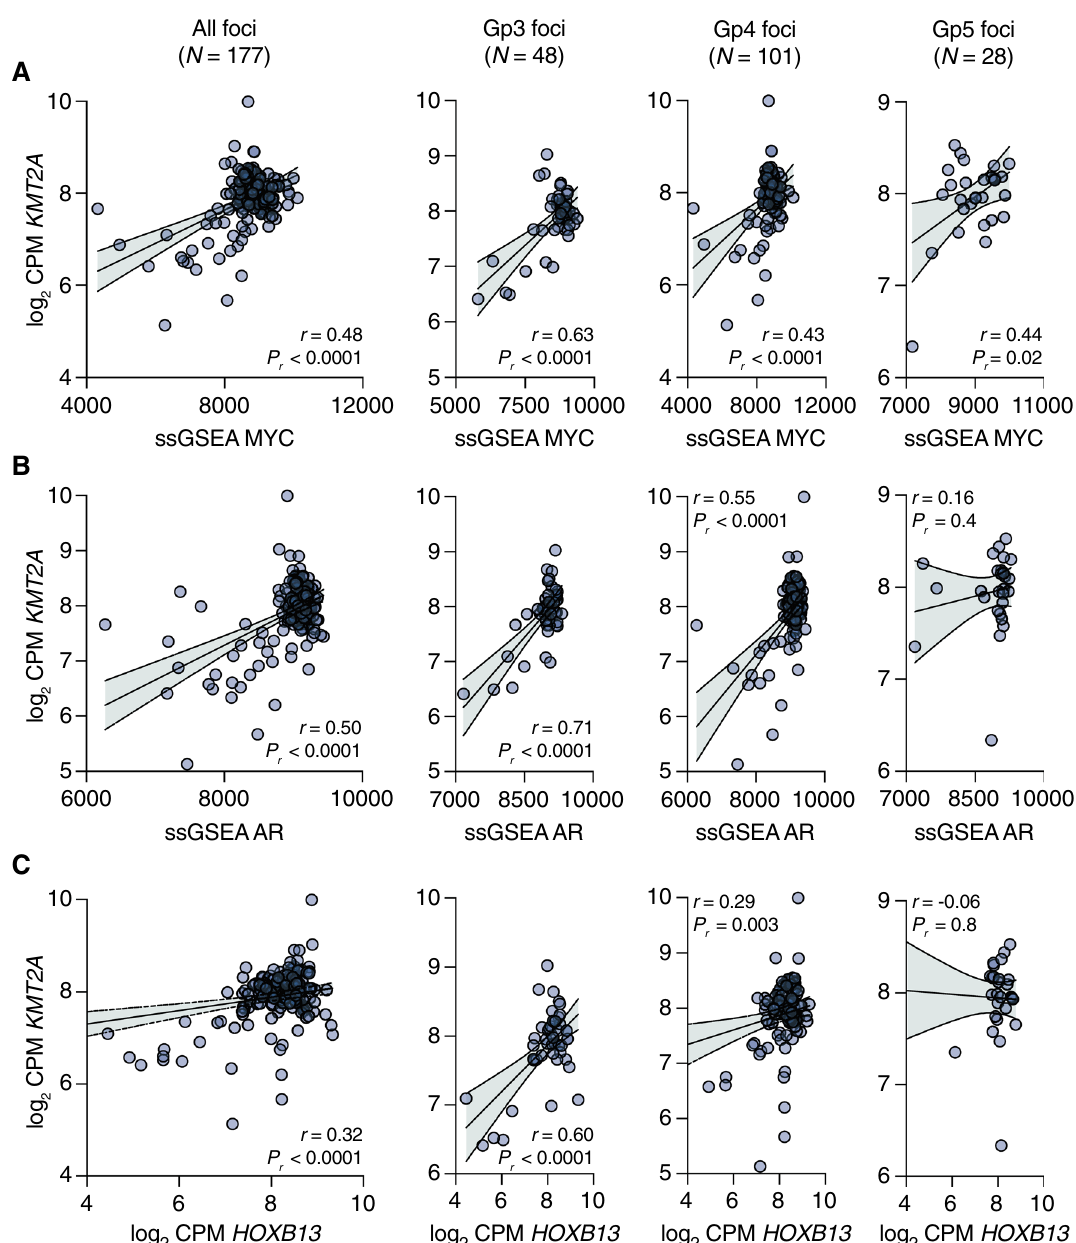
Fig. 2 Decreasing association of KMT2A expression with prostate cancer drivers during primary disease progression. A – C Pearson correla- tion of the log CPM expression level for KMT2A with a 54-gene ssGSEA MYC activity score ( A ), a 266-gene ssGSEA AR activity score ( B ), or 2 the log CPM expression level for HOXB13 ( C ) in a cohort of 177 laser capture microdissected foci of human prostate tumors. The error bars 2 represent the 95% confidence bands for linear regression. For each correlation, the foci are subdivided into Gp3 (left), Gp4 (middle, includ- ing intraductal tumors), and Gp5